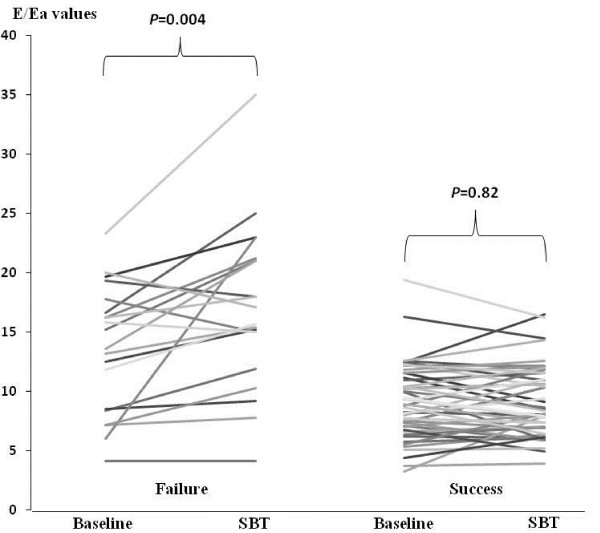
Individuals values of E/Ea mitral ratio in the failure and the success group. This figure represents individual values of E/Ea measured at baseline and during SBT for patients in failure group (A) and for patients in the success group (B). Significant increase in E/Ea occurs during SBT in the failure group while no variation in E/Ea is observed in the success group.